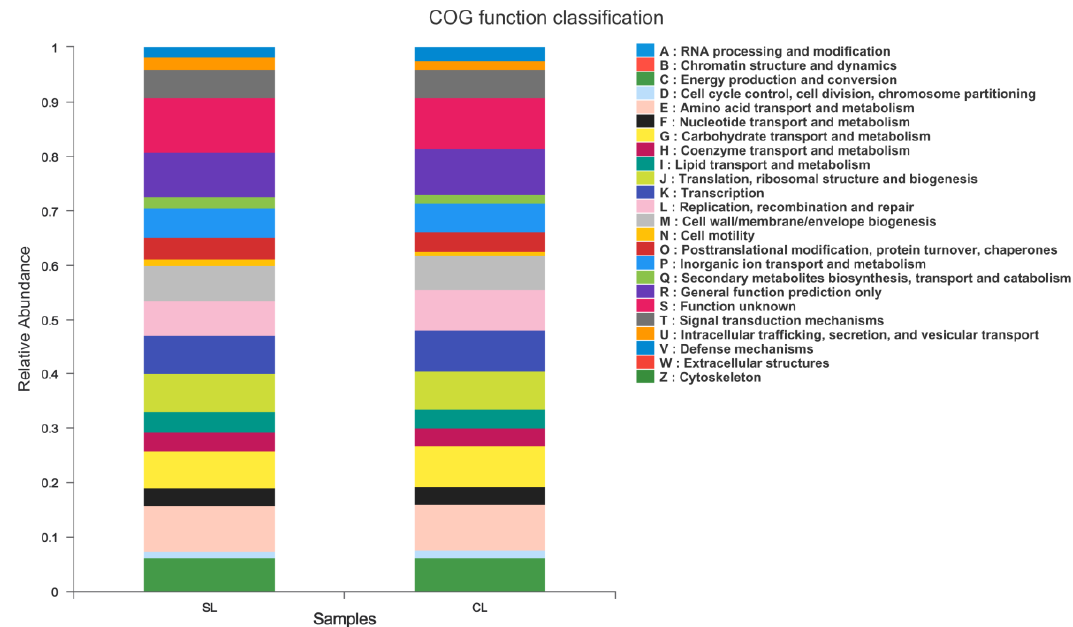
Figure 8. Statistical histogram of COG function classification of intestinal microbiota of SL and CL Anser fabalis.